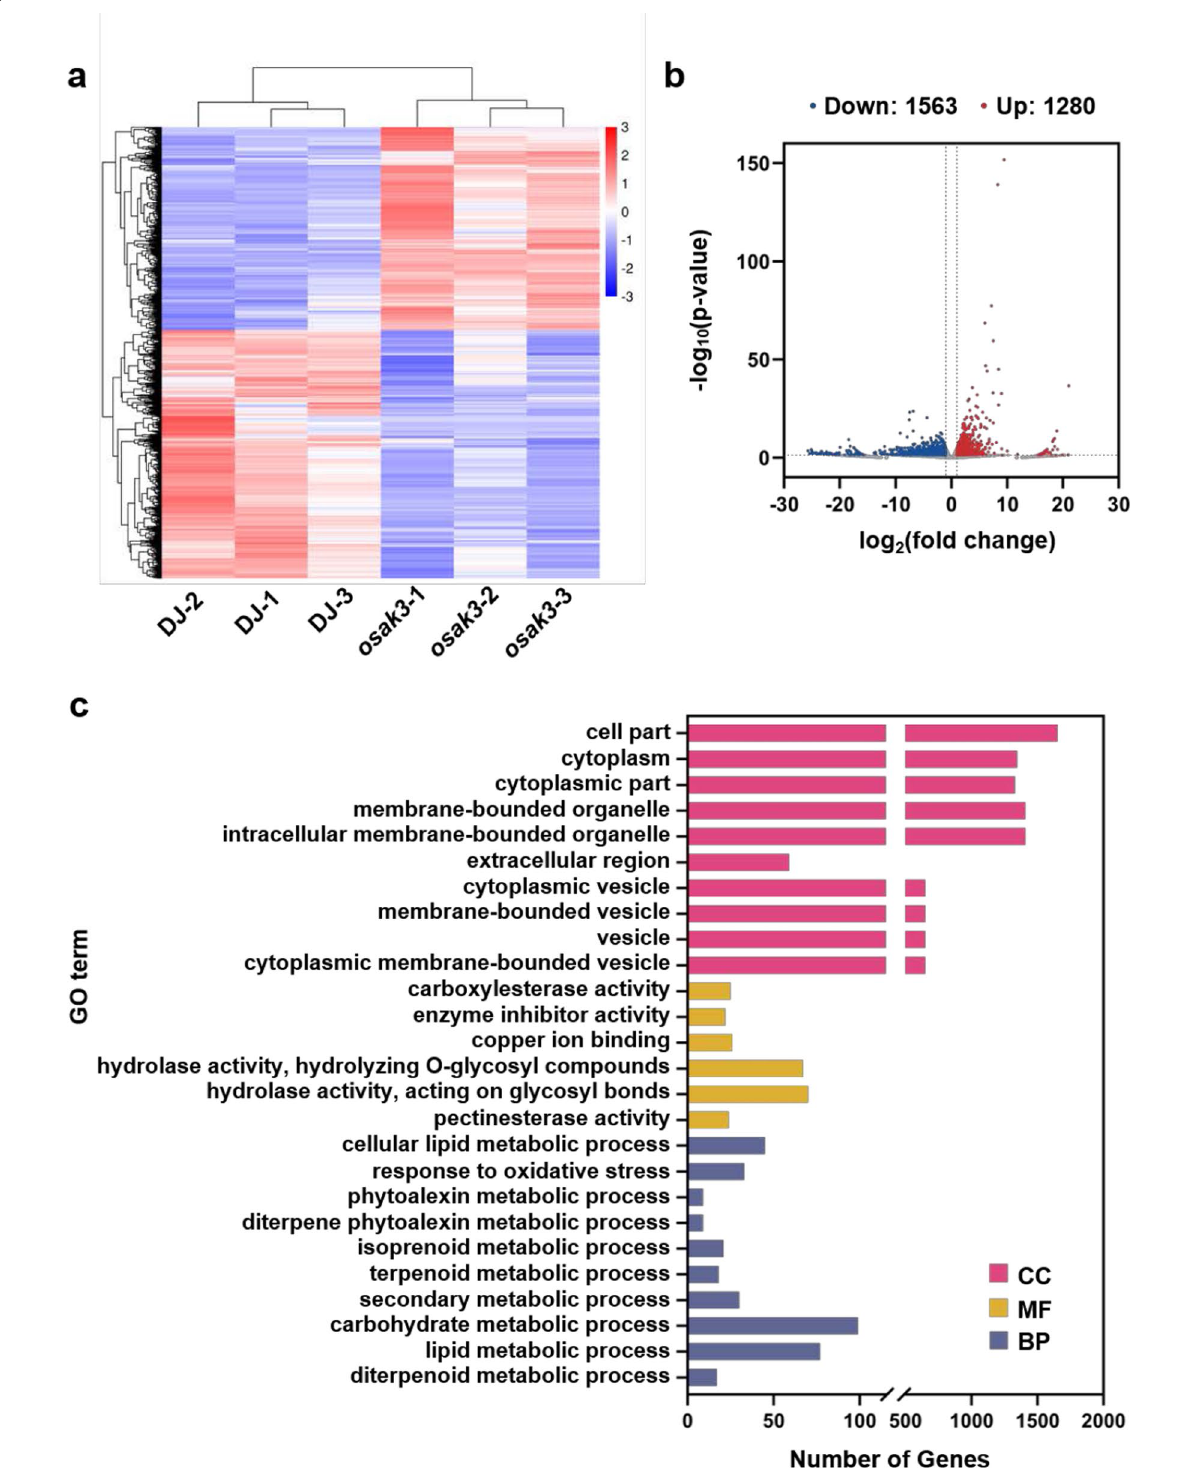
Fig. 7 RNA-seq shows that OsAK3 is involved in multiple metabolic pathways. a Hierarchical clustering of the DEGs between DJ and osak3 mutant plants. Each line with three biological replicates. DEGs were defined by absolute log2 Fold Change > 1 and P value < 0.05. Scale bar shows fold changes, values are normalized by z-score scheme, red and blue color indicate up- and down-regulated, respectively. b Volcano map of DEGs between DJ and osak3 . c Significantly enriched GO terms of DEGs between DJ and osak3 . GO terms were sorted based on FDR-adjusted P value <